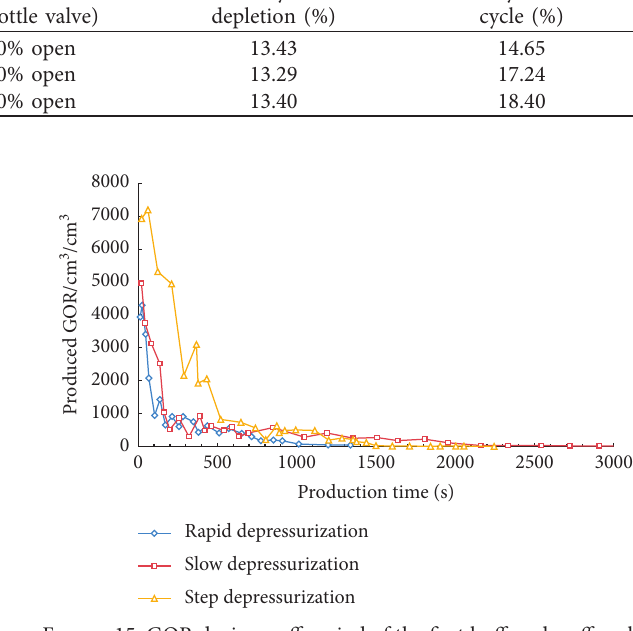
Figure 15: GOR during puff period of the first huff-and-puff cycle with different depressurization method.